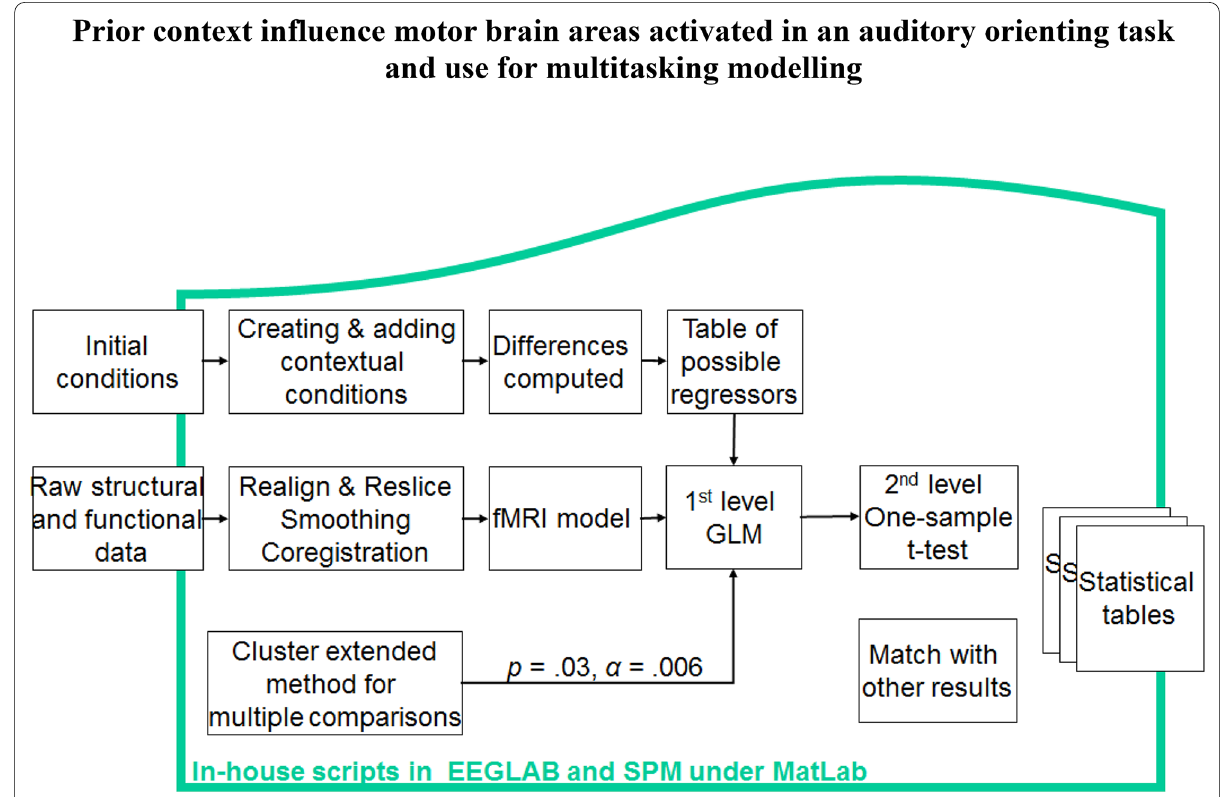
Fig. 1 Preprocessing and analysis diagram used for the auditory oddball task in the simultaneous EEG and fMRI